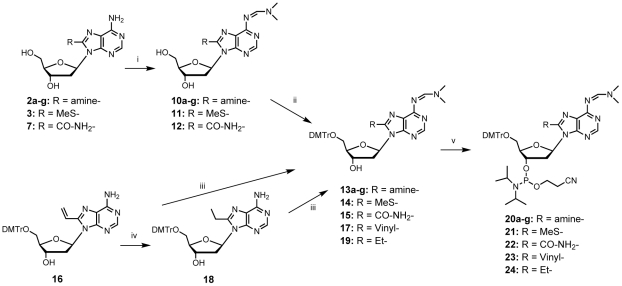
Synthesis of phosphoramidite building blocks 20 a–g, 21, 22, 23 and 24.(i) Me2NCH(OMe)2, MeOH, room temperature, 17 h; (ii) DMTrCl, pyridine, room temperature, 17 h; (iii) Me2NCH(OMe)2, DMF, room temperature, 4 h; (iv) H2, Pd/C (10%), EtOAc, CH2Cl2, room temperature, 4 h; (v) (iPr)2N(CE)PCl, (iPr)2NEt, CH2Cl2, room temperature, 2.5 h.